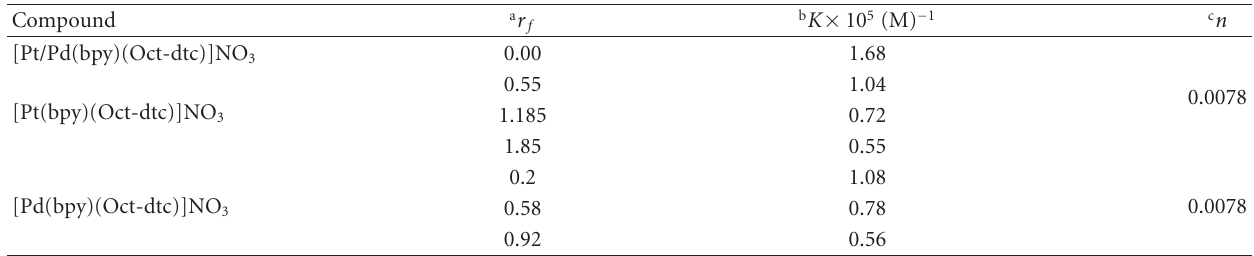
a Formal ratio of metal complex to nucleotide concentration. b Association constant. c Number of binding sites ( n ) per nucleotide.